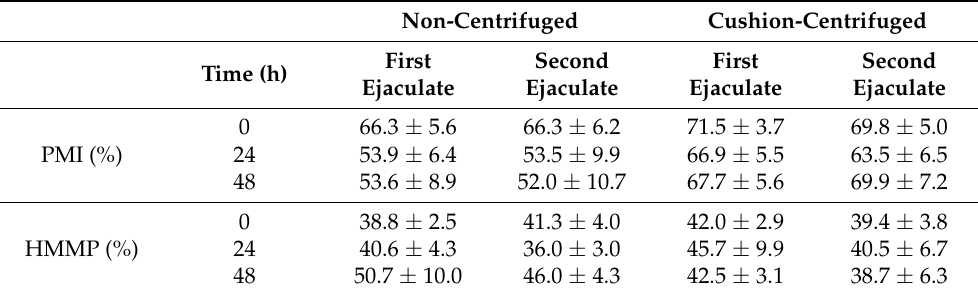
Table 9. Percentage of sperm with an intact membrane (PMI) and high mitochondrial membrane potential (HMMP) from the first and second ejaculates of the season collected from breeding inactive stallions (n = 20) after 0, 24, and 48 h of cooling. Non-Centrifuged Cushion-Centrifuged First Second First Second Time (h) Ejaculate Ejaculate Ejaculate Ejaculate 0 66.3 ± 5.6 66.3 ± 6.2 PMI (%)